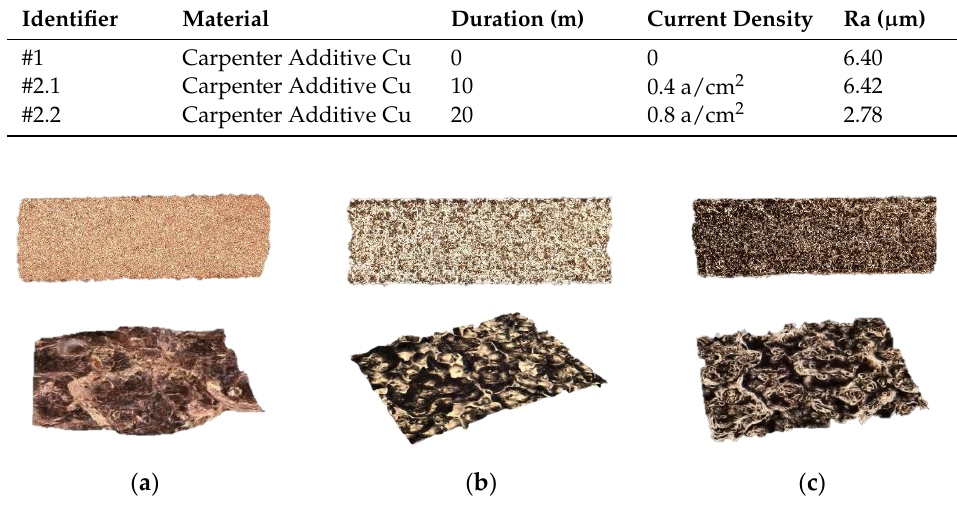
Figure 11. Surface roughness 3D visualisation of as-built and electropolished samples, where ( a ) is as-built, ( b ) is 0.4 a/cm 2 current density and ( c ) is 0.8 a/cm 2 current density.